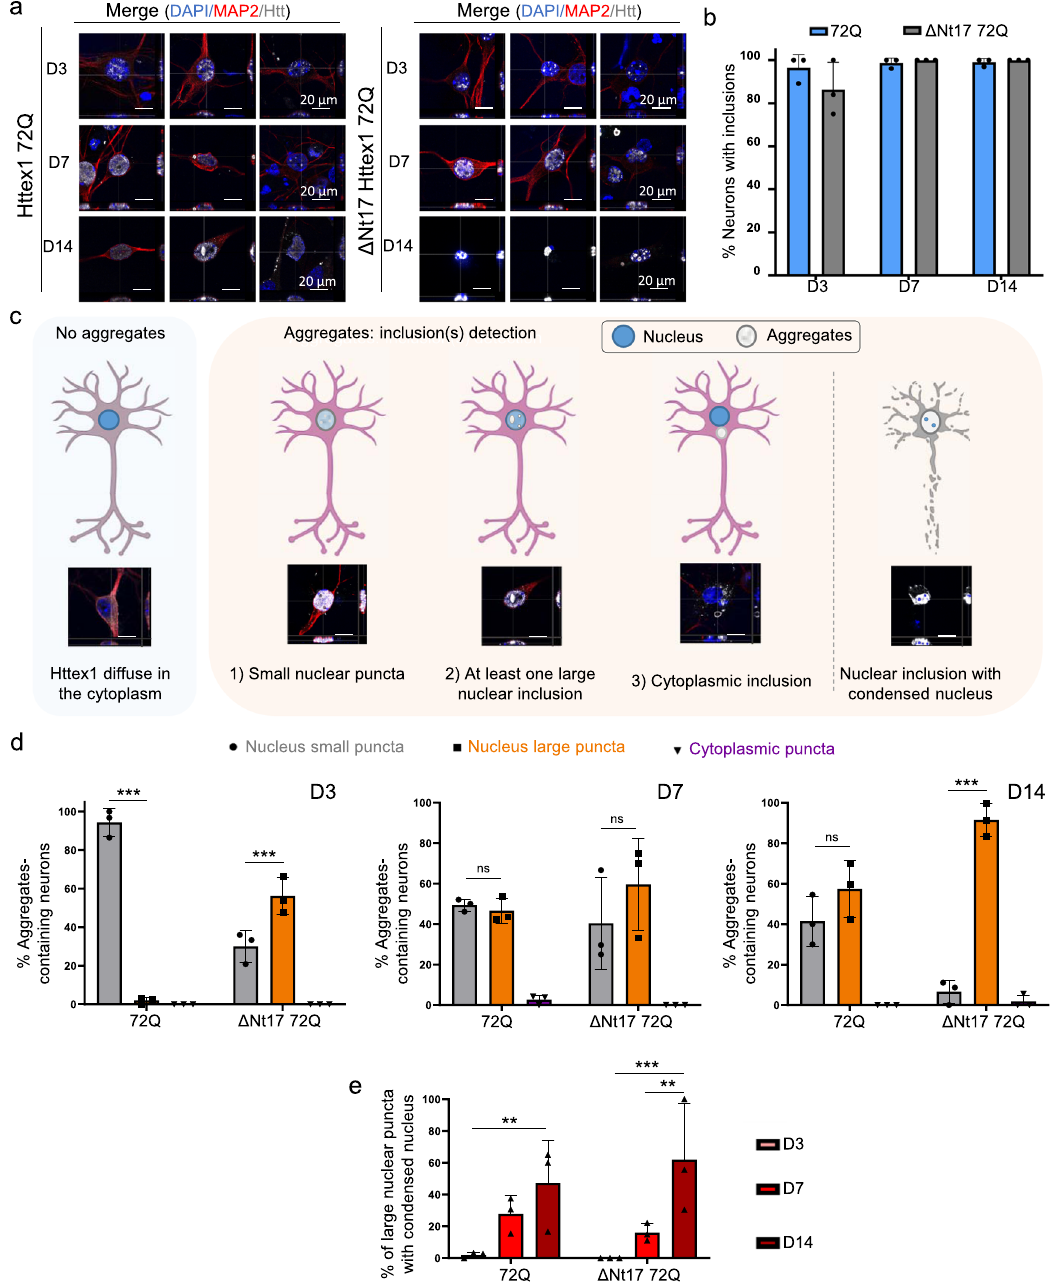
Fig. 5 Confocal microscopy analysis and classi fi cation of the Httex1 inclusions formed in neurons revealed their morphological heterogeneity. a Httex1 expression was detected by ICC staining combined with confocal imaging in primary cortical neurons, 3 (D3), 7 (D7), and 14 (D14) days after lentiviral transduction. Httex1 mutants were detected with the MAB5492 antibody. The nucleus was counterstained with DAPI (blue), and MAP2 was used to visualize the neurons (red). Scale bars = 20 μ m. b Image-based quanti fi cation of the number of neurons containing Httex1 inclusions over time. The graphs represent the mean ± SD of 3 independent experiments. c Primary neurons were classi fi ed via the detection of Httex1 as diffuse or by the morphology of the detected Httex1 aggregates: (1) Small nuclear puncta; (2) at least one large nuclear inclusion, and (3) cytoplasmic inclusion. In addition, a subclass was created for neurons containing a large nuclear inclusion associated with nuclear condensation. Scale bar = 20 μ m. d Image-based quanti fi cation and classi fi cation of the different morphologies of Httex1 inclusions based on the panel c . A minimum of n = 145 cells per condition were examined over 3 independent experiments. Data are presented as mean values + / − SD. Statistical analysis: One-way ANOVA followed by a Tukey [HSD] post hoc test was performed. p -values < 0.0001 for top and bottom panels and * P < 0.05, ** P < 0.005, *** P < 0.001 for multiple comparisons. e Image-based quanti fi cation of neurons containing a large nuclear inclusion with a nuclear condensation. A minimum of n = 145 cells per condition were examined over 3 independent experiments. Data are presented as mean values + / − SD. Statistical analysis: Two-way ANOVA revealed no signi fi cant interaction ( p - value = 0.0598) but a signi fi cant row factor samples ( p -value = 0.0076) and column factor time ( p -value = 0.0002) with * P < 0.05, ** P < 0.005, *** P < 0.001 for multiple comparisons.